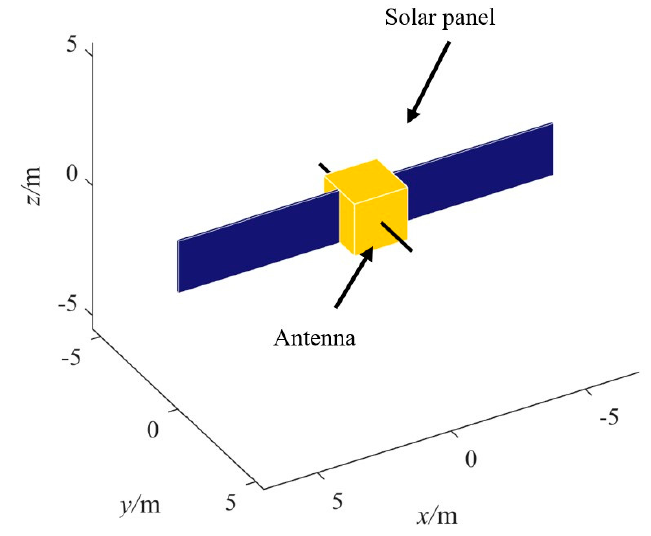
Figure 3. Complex shape of target spacecraft. Table 1. The initial key parameters of Gaussian mixture model (GMM).